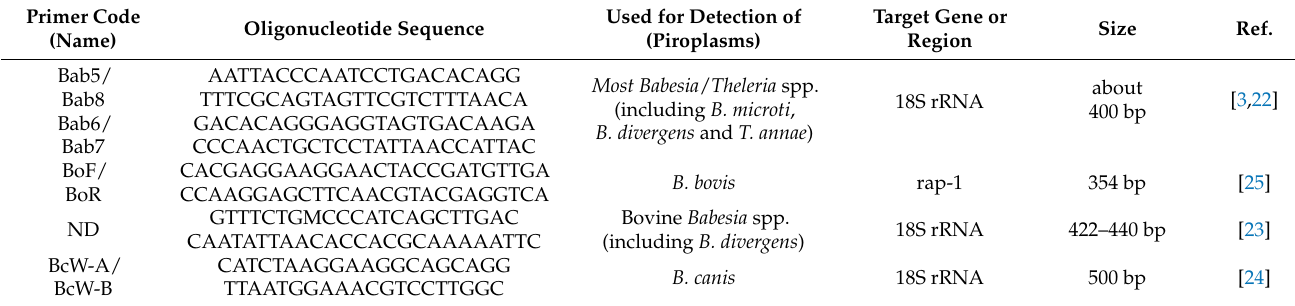
Table 1. Primers used for amplification of PCR.